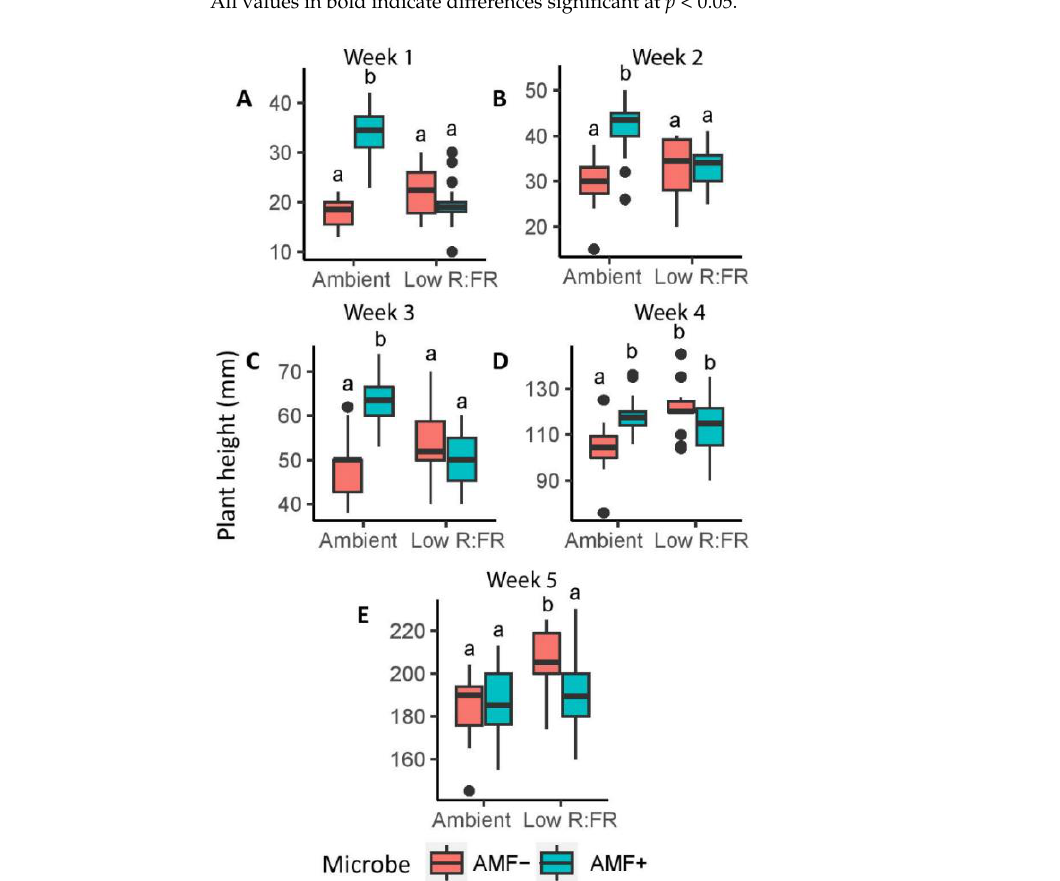
Figure 2. Height of tomato plants during the first five weeks ( A – E ) after seedling transplantation grown under two light (Ambient and Low R:FR) and two inoculation treatments (AMF − : no mycorrhizae, AMF+: mycorrhiza). Boxplots that don’t share the same letter are significantly different p < 0.05 (Tukey HSD). The median is represented by the thick horizontal line; the box is defined by the 25th and 75th percentiles (lower and upper quartile).